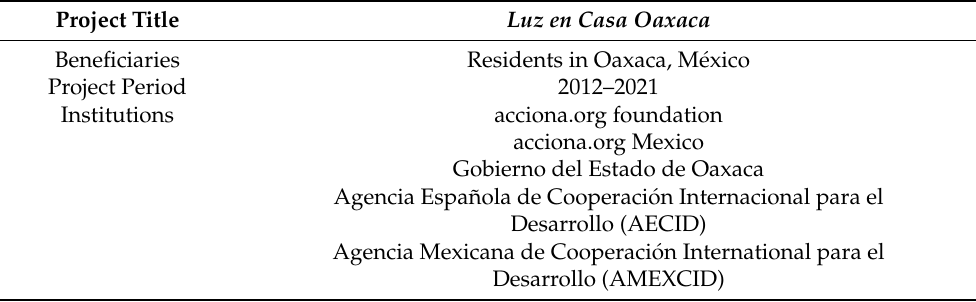
Table 3. “Luz en Casa Oaxaca”: Project